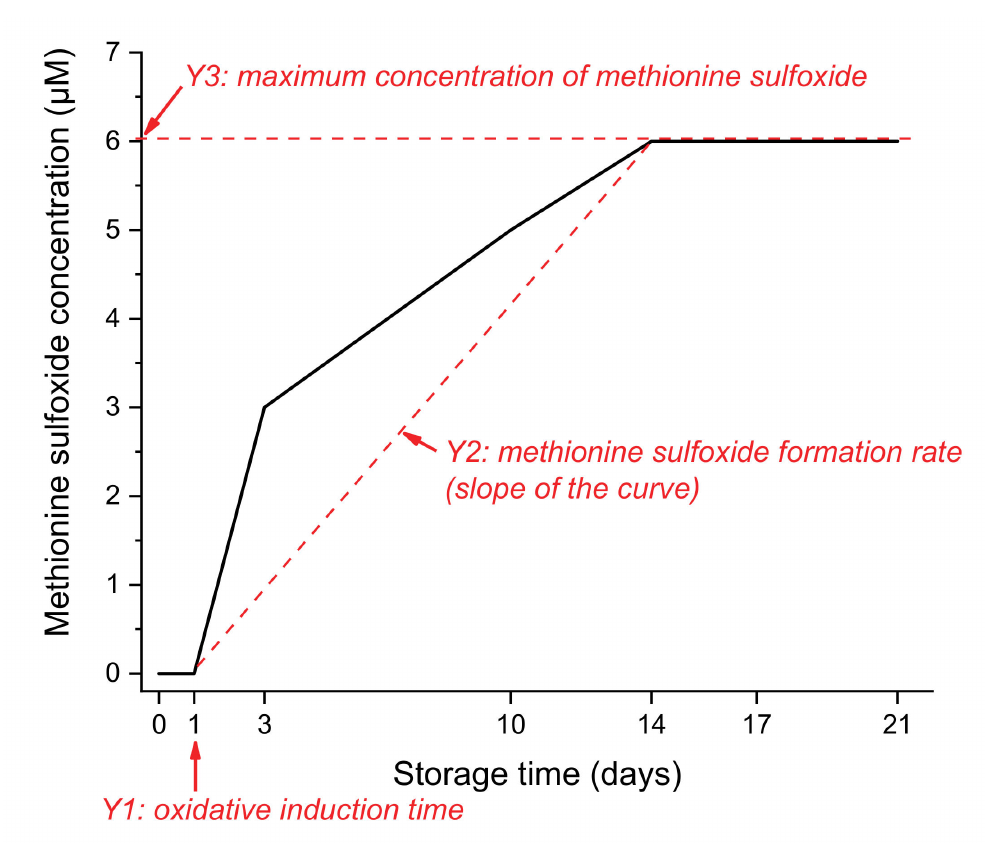
Figure 3. A plot of storage time vs methionine sulfoxide concentration generated to exemplify the three responses used in the experimental